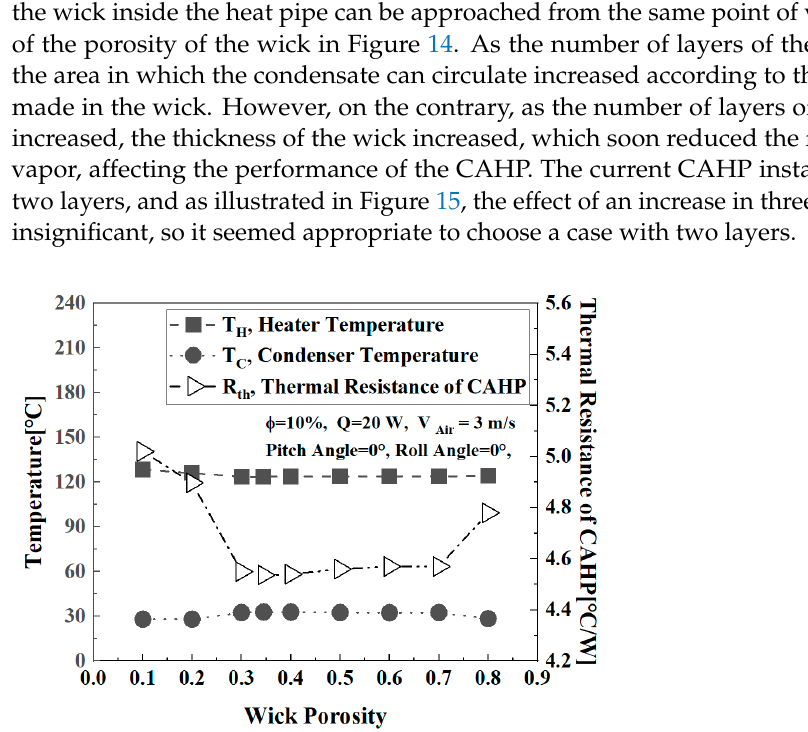
Figure 15. Simulated thermal characteristics of the CAHP according to the layers of the wick ( V air = 3 m/s, Q = 20 W, pitch angle = 0°, and roll angle = 0°). 6. Conclusions In the current study, concentric annular heat pipes (CAHPs) were experimentally studied under various conditions, and the results were compared and verified by one- dimensional modeling. The operating characteristics were analyzed by applying a heat pipe with an annular structure that had not been applied before as a heat sink. The capac- ity of the working fluid inside the CAHP, the amount of heat supplied, the flow rate of the cooling air, and the operating characteristics according to the inclination in various directions could be confirmed. If the filling amount was 10%, it was observed that the orientation had a large impact. This is believed to be due to the partial drying of the surface inside the evaporator. If the amount of heat supplied increased, the thermal resistance of the CAHP de- creased. When Q was 20 W, the lowest value was 3.74 °C/W. The experimental results showed that the performance of the CAHP was best when the roll angle was 15° and the internal vapor flow was improved. However, in the one- dimensional modeling, it was difficult to implement a structure in which the entire system changed its position at various angles, and its performance was compared only with mod- eling in a vertical state.